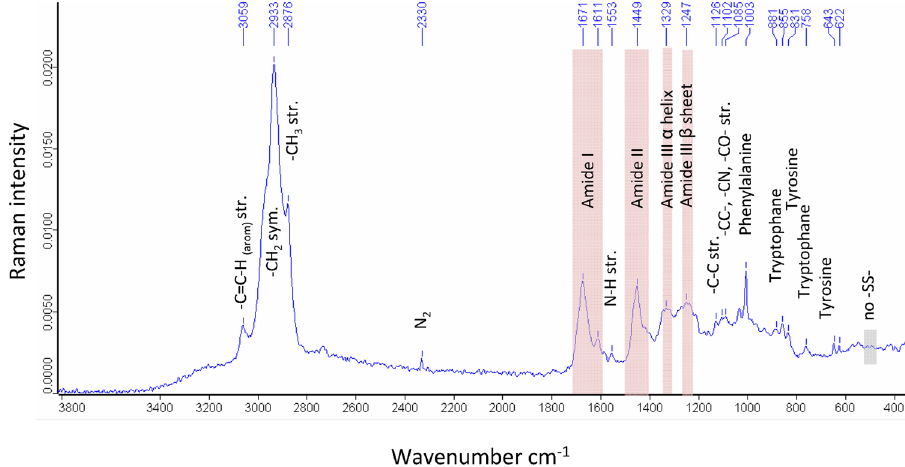
Figure 4. Raman spectrum of the dry salamander secretion. The region between 3.800 and 380 cm − 1 is magnified and prominant vibrations from amide bonds have been colored red. Addtional vibrations, e.g. typical for amino acids, have been added to the